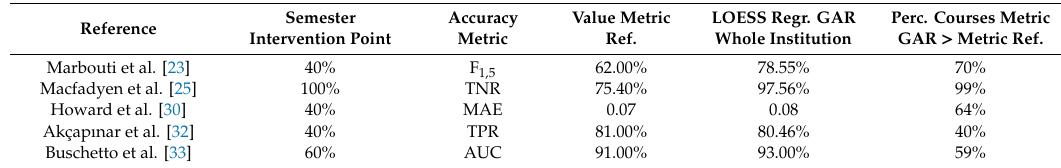
Table 1. Comparison GAR Model with other related